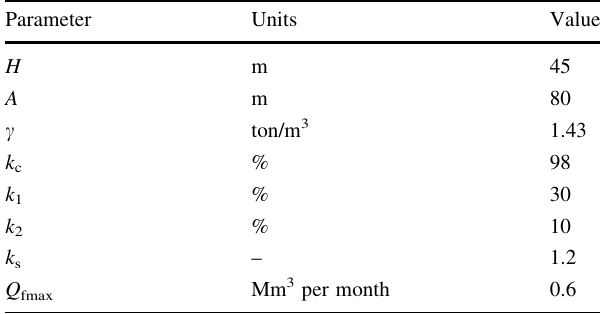
Fig. 6 Improvement flow chart of dragline stripping system